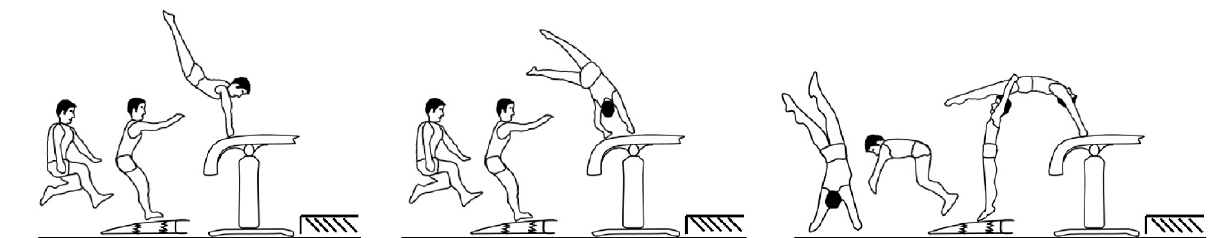
Figure 1. Different vault styles. The different first flight phases of the three most common vault styles in male artistic gymnastics. Left: Handspring; middle: Tsukahara; right: Yurchenko.